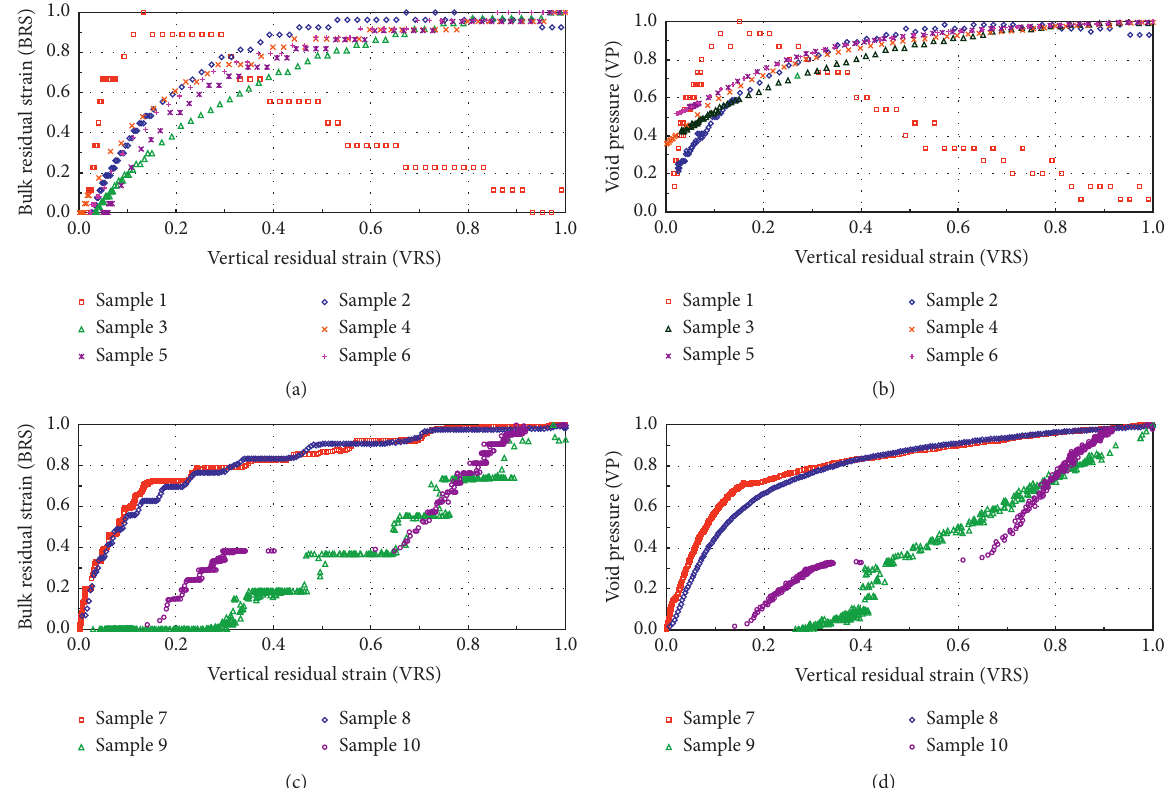
Figure 8: Relationship between vertical residual strain, bulk residual strain, and void pressure (the same normalized method as shown in Figure 2). (a) Samples 1–6 (US/SS). (b) Samples 1–6 (US/SS). (c) Samples 7–10 (SD/UD). (d) Samples 7–10